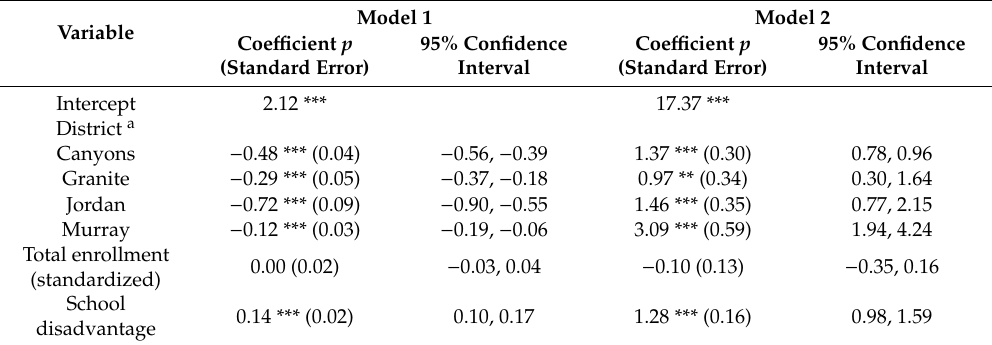
Table 2. Results of the generalized estimating equations (GEEs) predicting chronic (annual daily average, 2016) PM 2.5 concentrations (Model 1) and the frequency of peak (number of days above